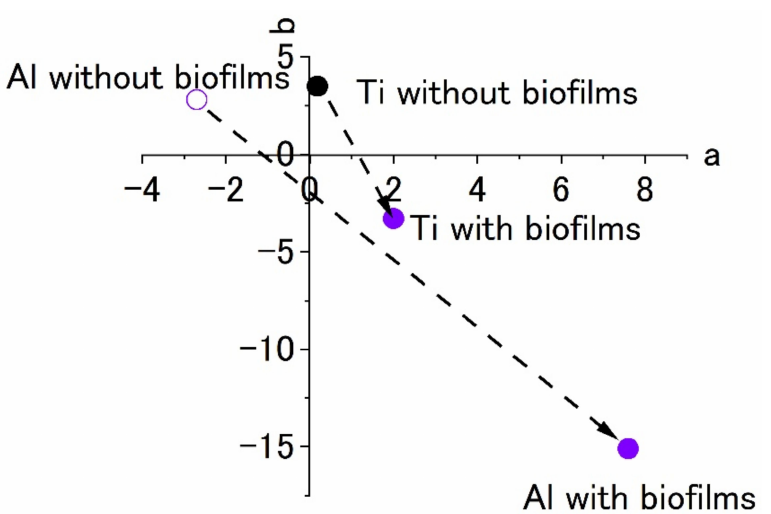
Figure 12. Raman shifts by the CLCLBR: ( a ) titanium specimen and ( b ) aluminum specimen.